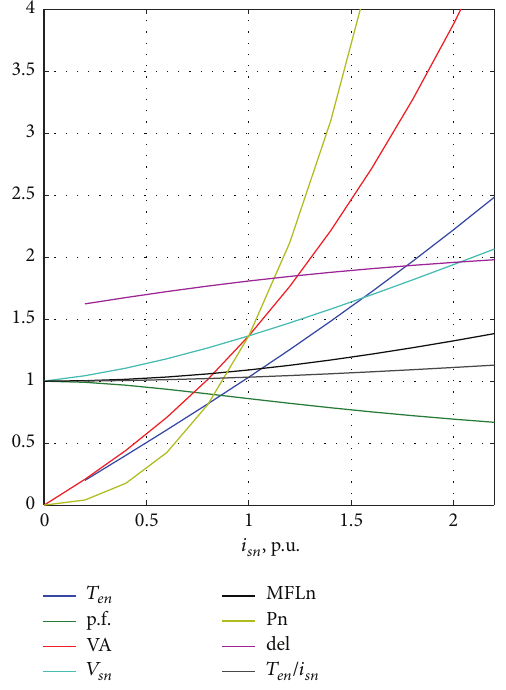
Figure 4: Performance characteristics of PMSM for optimum torque per unit current control.